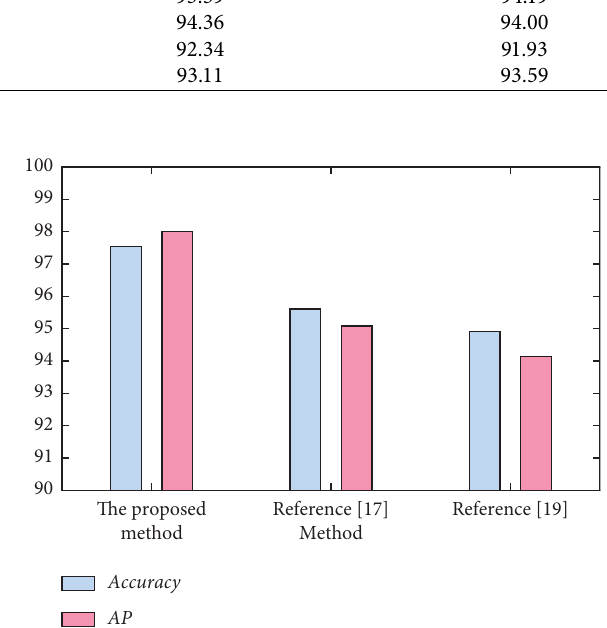
Figure 8: Image analysis performance of diferent analysis methods.